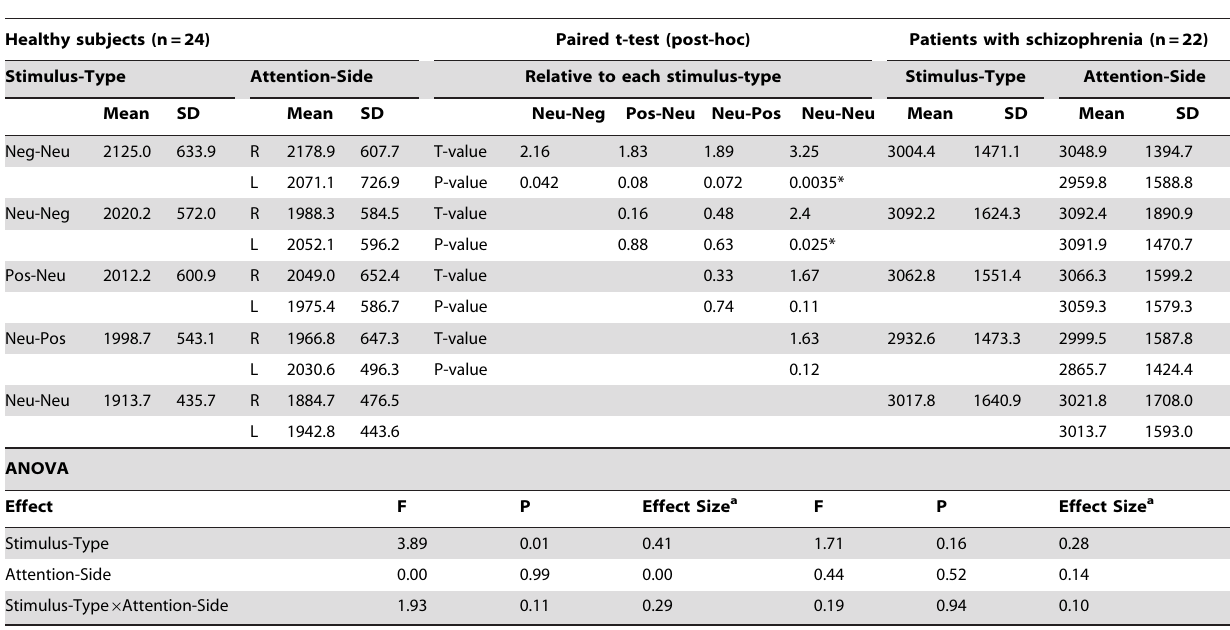
Table 2. Reaction time